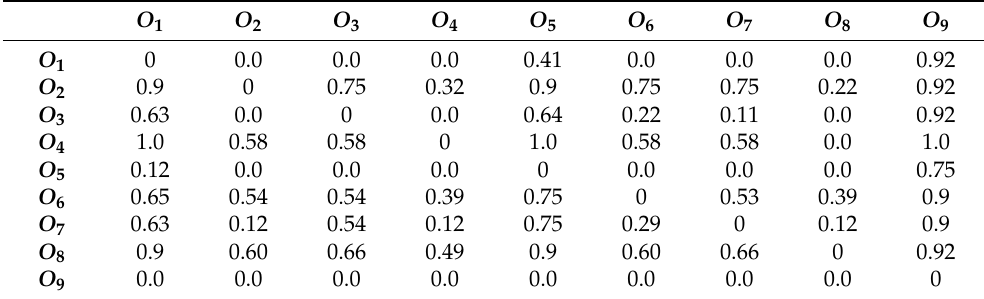
Table 27. Discordance matrix for PLTS ELECTRE II.